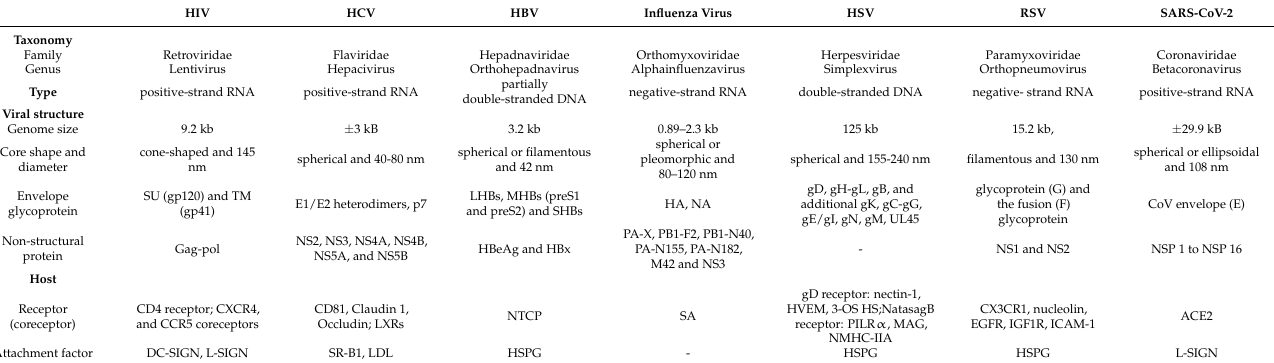
Table 1. Virus taxonomy, virus type, particle structure, and host